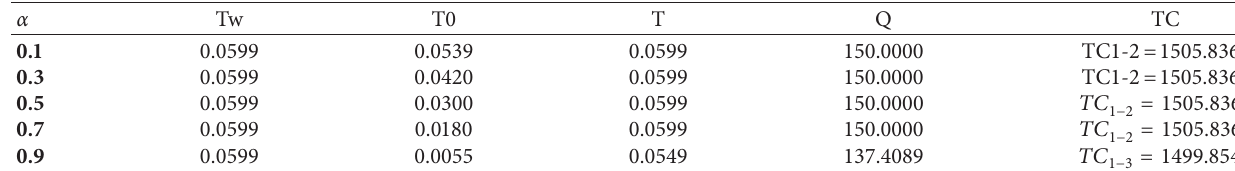
Table 6: The obtained solutions under different values of α